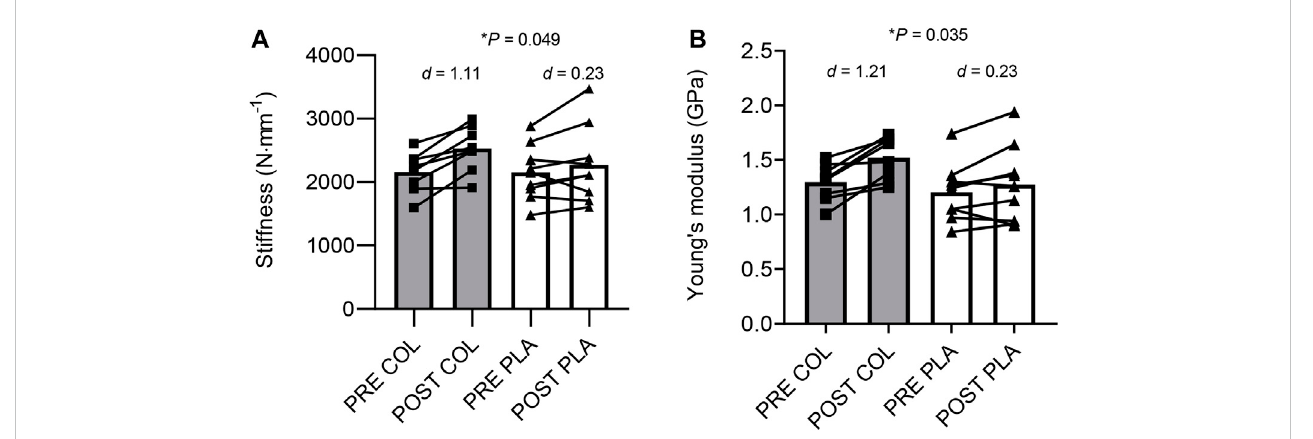
FIGURE 1 Changes in tendon stiffness (A) and Young ’ s modulus (B) in collagen (COL) and placebo (PLA) groups before (PRE)and after (POST) training. d = Cohen ’ s d ; *Signi fi cant group × time interaction